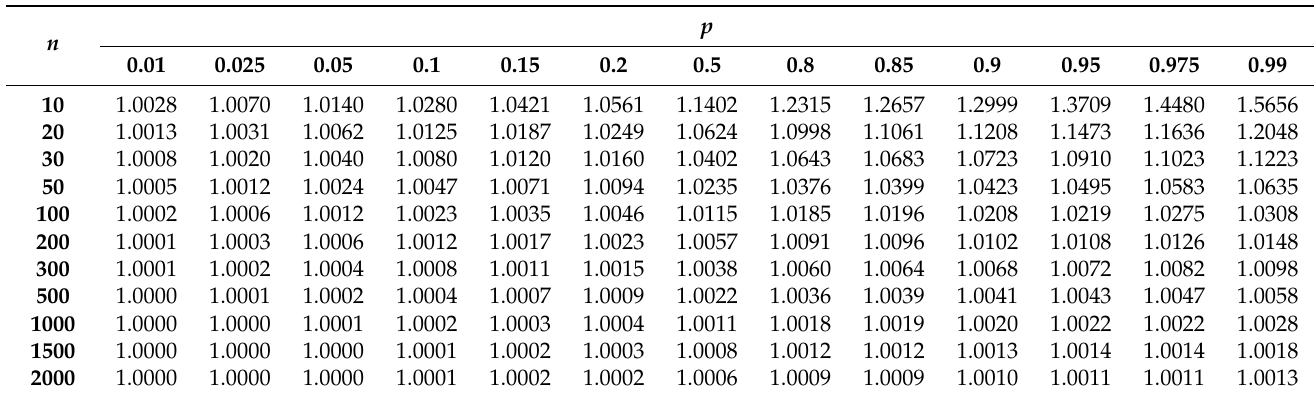
( q ) = P (cid:0) V n ≤ q (cid:1) = p —Known Table 1. F V n